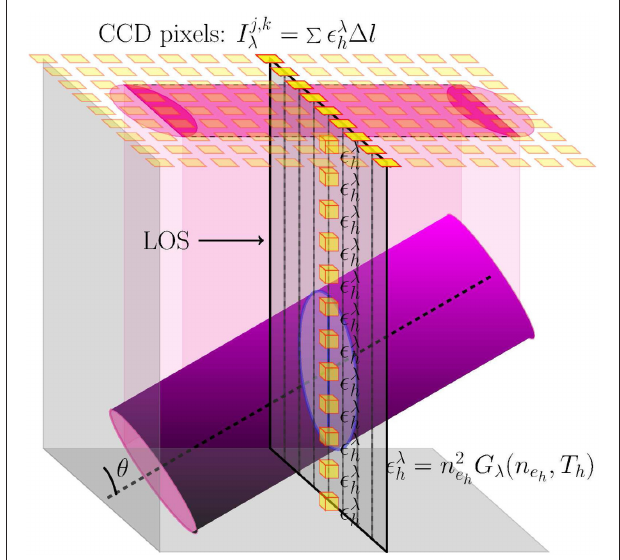
FIGURE 1 | A schematic representation of the LOS through the simulation box in FoMo. The yellow boxes are the voxels along a specific LOS. Figure taken from Yuan et al.